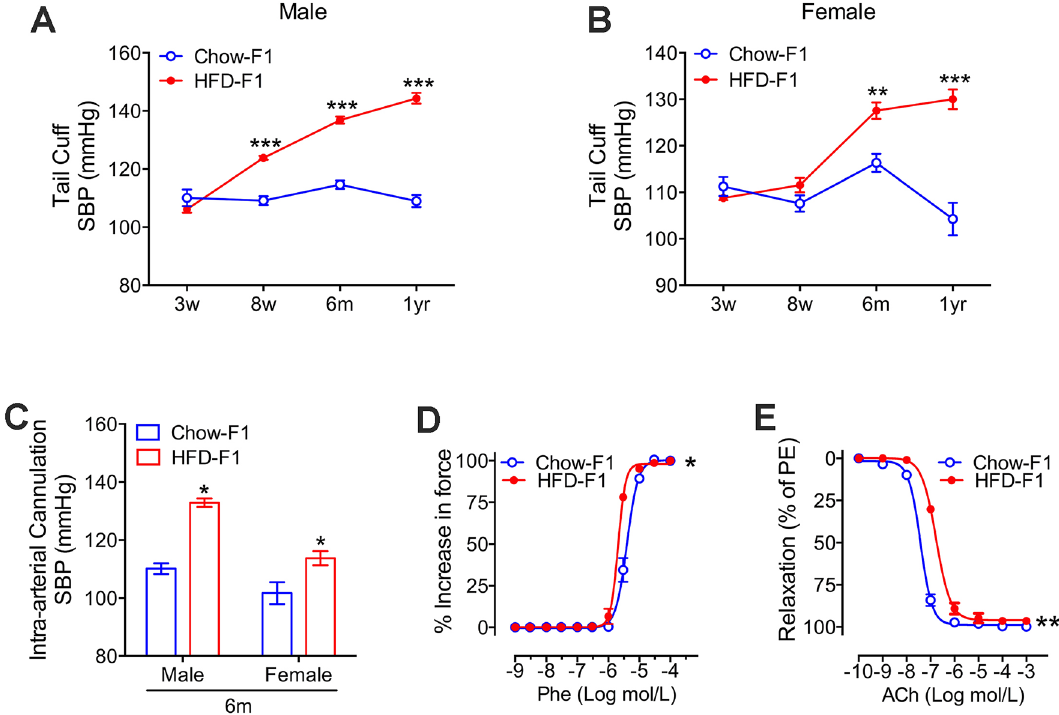
Figure 2. Maternal hyperlipidemia is associated with sustained elevated blood pressures, enhanced contraction, and reduced relaxation functions of the mesenteric arteries. ( A ) Tail cuff systolic blood pressures (SBP) in male chow-exposed and high-fat-diet (HFD)-exposed offspring (n = 6 for each group). ( B ) Tail cuff SBP in female chow-exposed and HFD-exposed offspring (n = 6 for each group). ( C ) Intra-arterial cannulation SBP in 6-month-old chow-exposed and high-fat-diet (HFD)-exposed offspring (n = 5 for each group). ( D ) The contractile responses of the mesenteric arteries to phenylephrine in one-year-old HFD-exposed and control male rat offspring (Phe, n = 3). The concentration for 50% of the maximal effect (EC 50 ) in contraction is 3.973 × 10 –6 M (Chow-F1) and 2.063 × 10 –6 M (HFD-F1). ( E ) The endothelium-dependent vasorelaxation in Values in ( A , B ) are expressed as means ± SEs, *** p < 0.0001 ** p < 0.01, * p < 0.05, compared to the corresponding